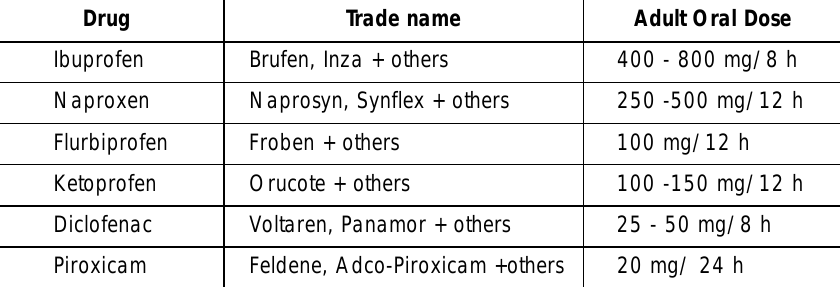
Table 1: Some generic and selected trade names for systemic NSAIDs (non-specific COX-1 and COX-2 inhibitors) Drug